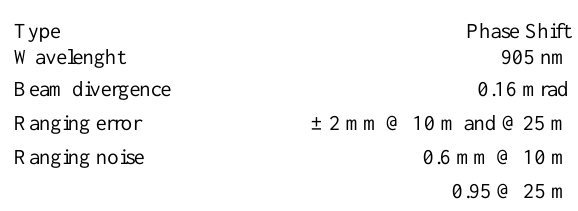
Table 1. TLS technical specification.